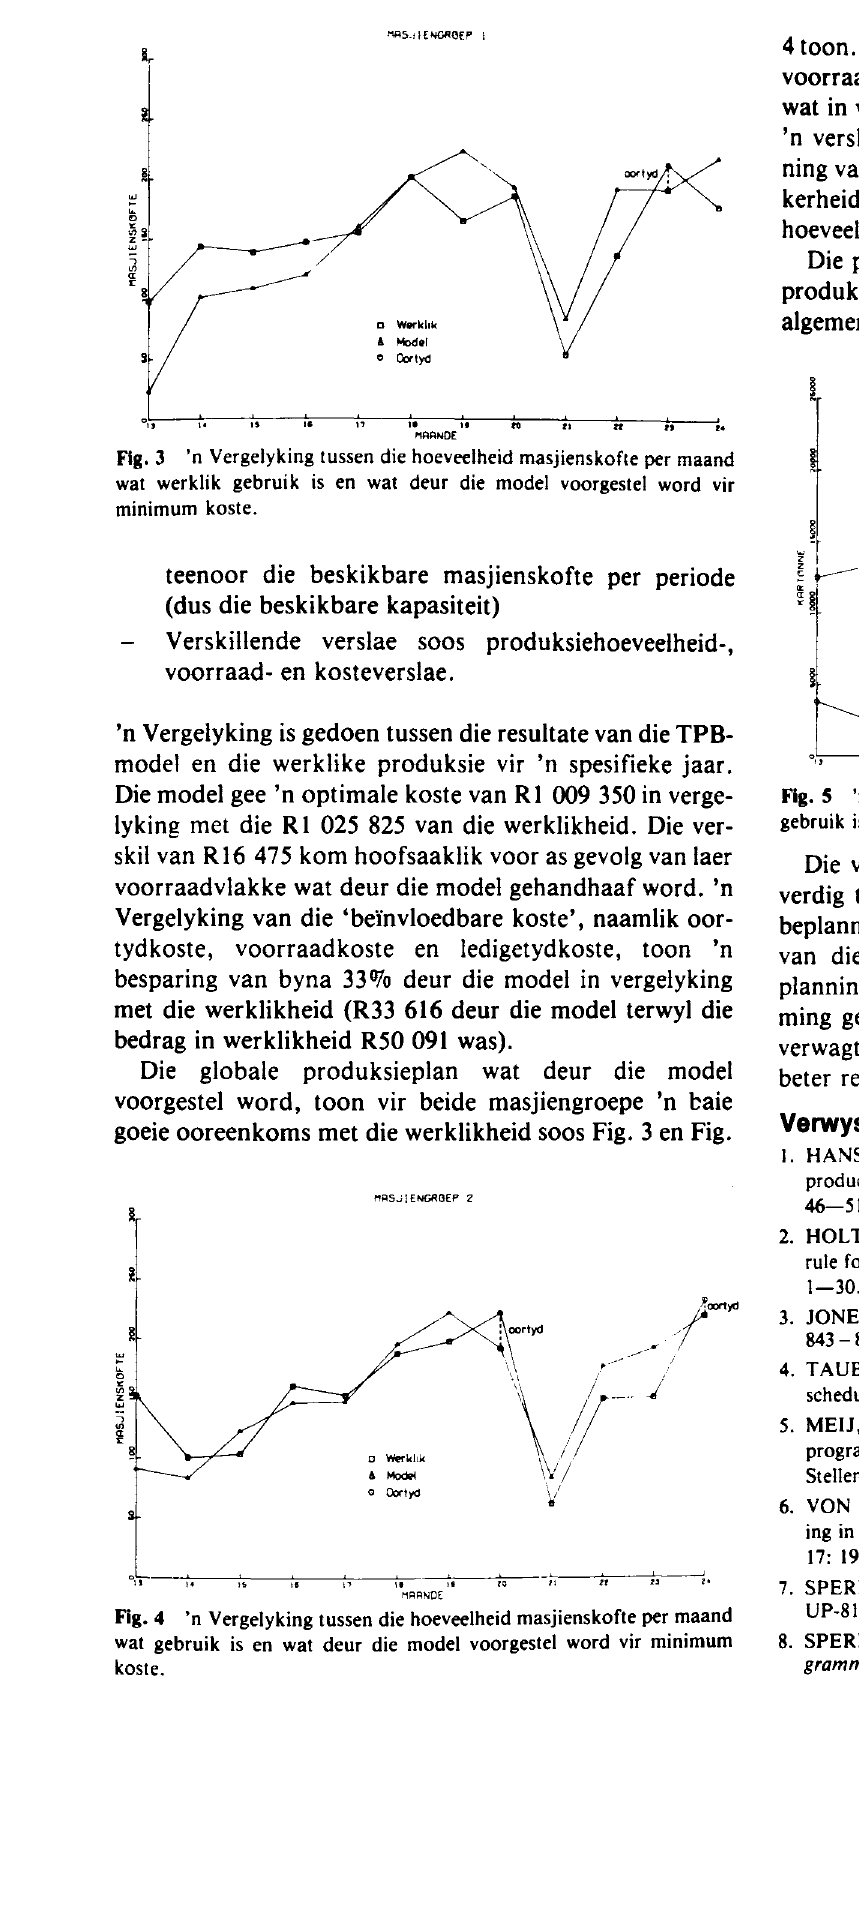
Fig. 4 'n Vergelyking tussen die hoeveelheid masjienskofte per maand wat gebruik is en wat deur die model voorgestel word vir minimum koste.